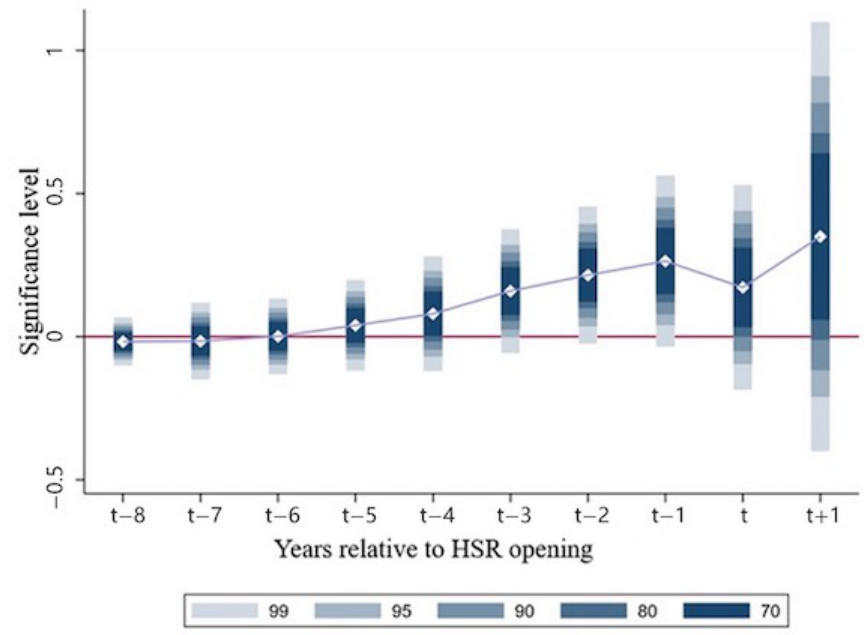
Figure 5. Parallel trend test